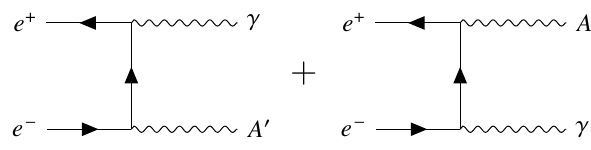
Figure 2 . Diagrams contributing to the process under